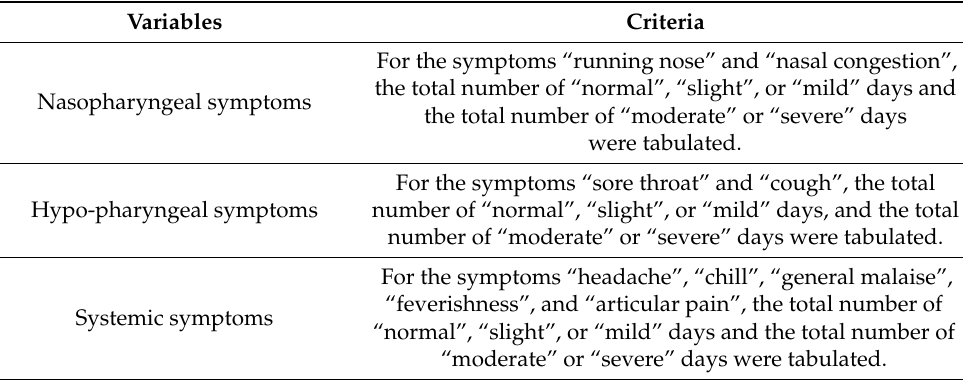
Systemic symptoms